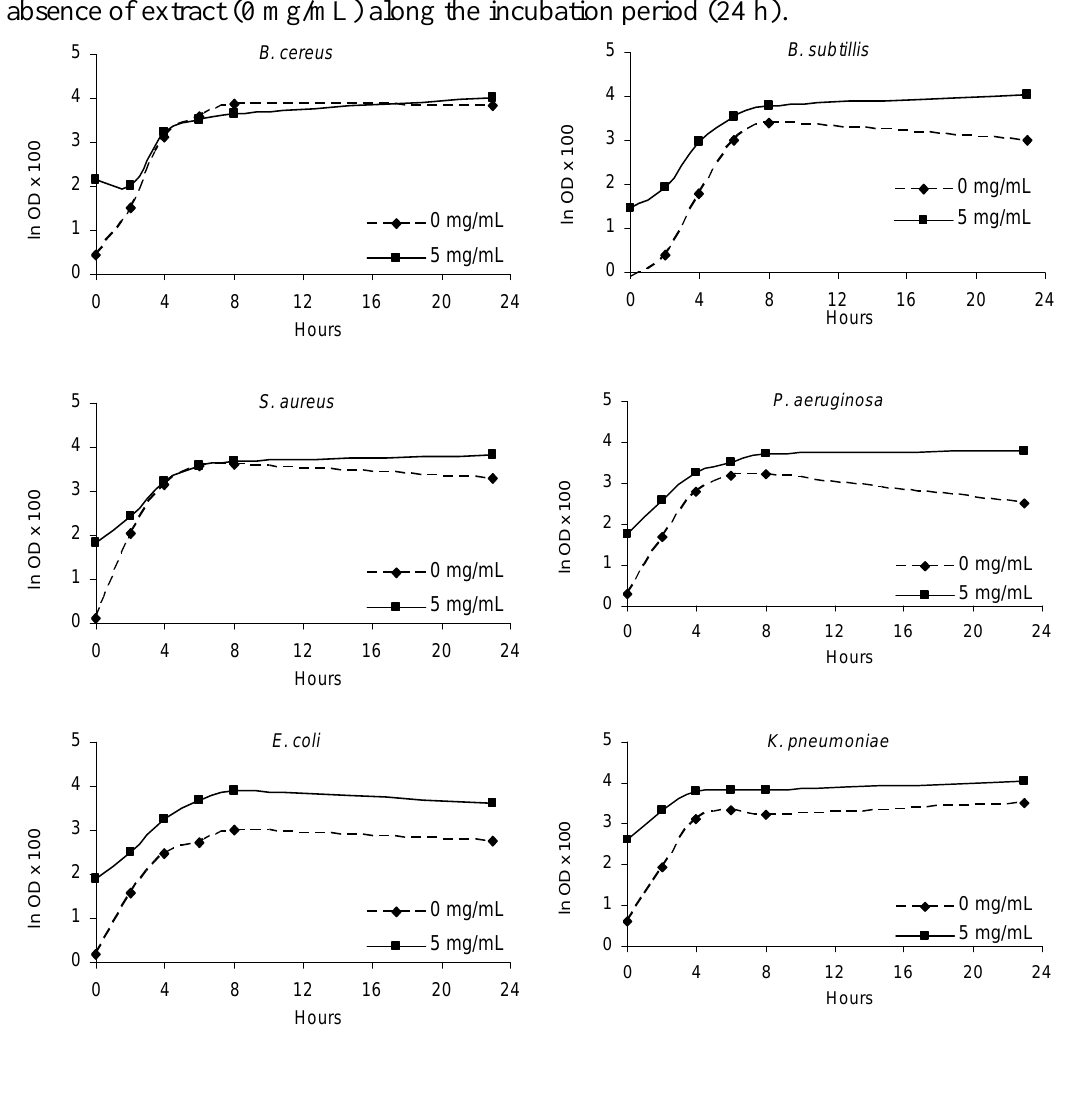
Figure 3. Bacterial growth in the presence of olive leaves extract (5 mg/mL) and in the absence of extract (0 mg/mL) along the incubation period (24 h).